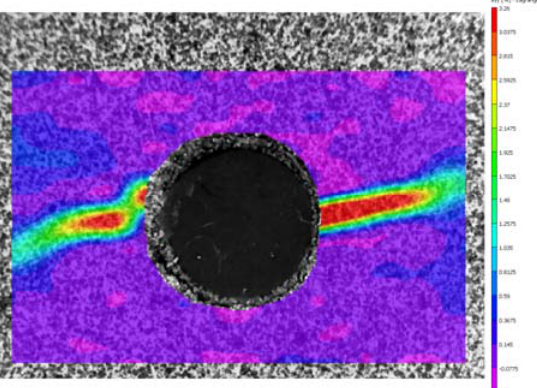
Figure 9: Analysis of the specimen immediately after plastic collapse. Grain size = 0.07